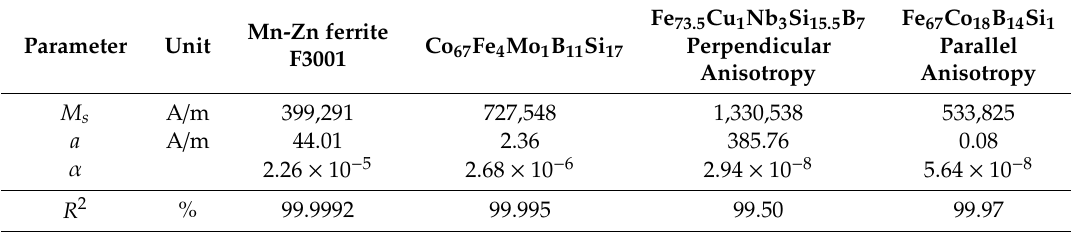
Table 3. Parameters of anhysteretic curve atan-based model identified during the optimization process.